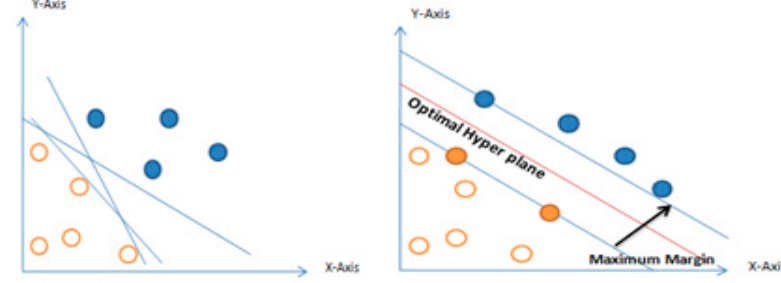
Figure 5. Support vector machine